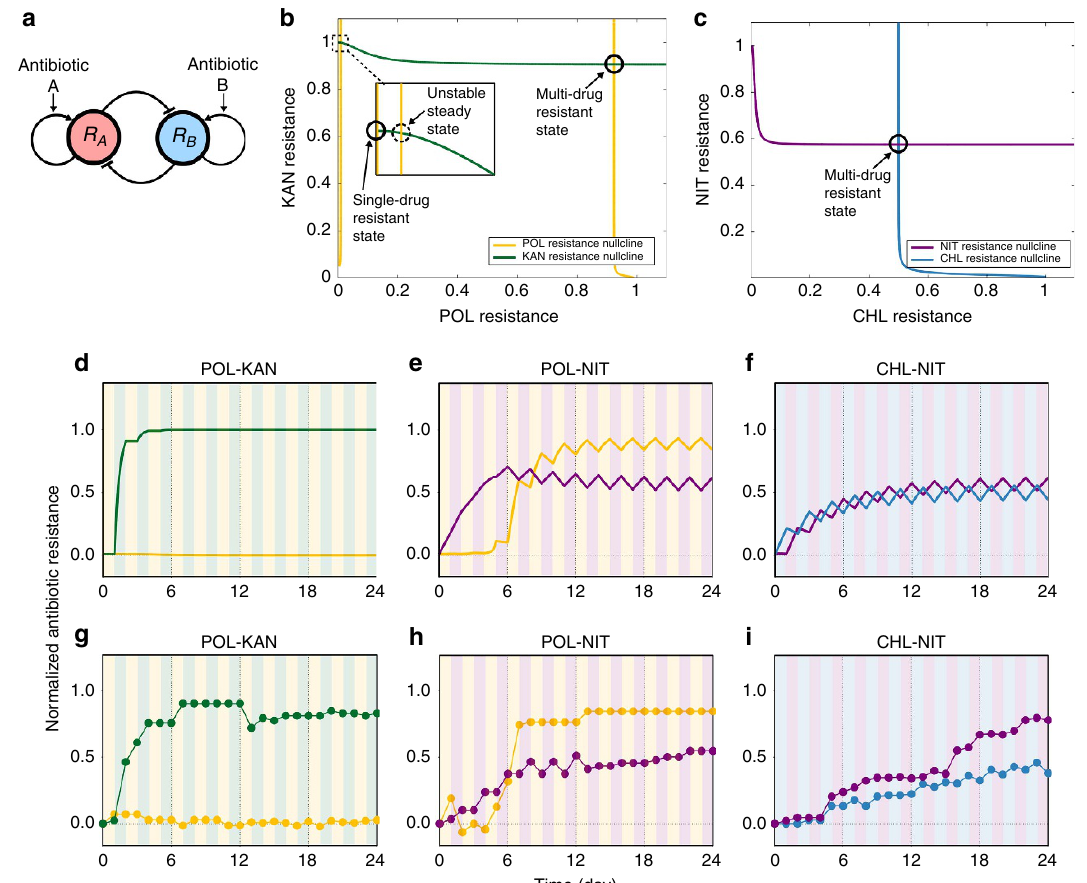
Figure 3 | Theoretical models of multi-drug resistance evolution. ( a ) Schematic diagram of the model consisting of positive autoregulation and double negative feedback loops. ( b ) Phase space of multi-drug evolutionary dynamics with POL and KAN. Two solid circles indicate stable steady states, corresponding to single and multi-drug-resistant states, respectively. A broken circle is an unstable steady state. MICs were normalized to one by the maximum MIC of single antibiotic evolution. ( c ) Phase space of multi-drug evolutionary dynamics with NIT and CHL. Only one stable steady state, multi-drug-resistant state, exists in this case. ( d – f ) Simulated evolutionary trajectories of bacterial resistance with POL and KAN, POL and NIT, and CHL and NIT, respectively. Antibiotics were cycled with 1 day interval. ( g – i ) Experimental data collected from the morbidostat